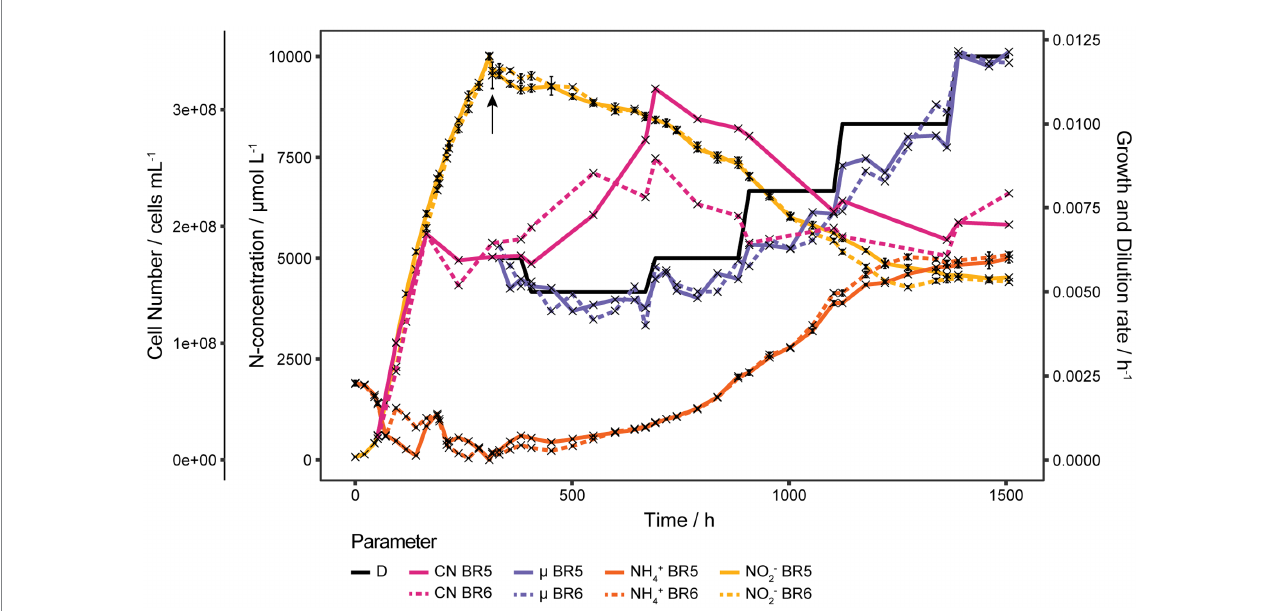
FIGURE 5 Continuous cultures of N. viennensis at high ammonia concentrations. Two continuous cultures gassed with 2 sL L − 1 h − 1 0.5% CO 2 enriched air, operated at D = 0.005 h − 1 to 0.012 h − 1 and the development of cell number (CN), NO 2 − derived μ , NH 4+ and NO 2 − concentrations of the cultures grown in the corresponding reactors BR5 and BR6. Batch cultures were grown with 2 mmol L − 1 NH 4 Cl and 1 mmol L − 1 pyruvate and then fed with medium containing 32 mmol L − 1 NH 4 Cl and 4.75 mmol L − 1 pyruvate to reach a final concentrations of 10 mmol L − 1 NH 4 Cl and 2 mmol L − 1 pyruvate. The relative reduction of pyruvate to NH 4 Cl caused a stagnation of the cell number, for which reason pyruvate was added to the cultures at the end of the feed phase (indicated by the arrow) to increase the concentration to 5 mmol L − 1 . Cell number increased as a result of ROS detoxification by pyruvate, but started to decrease again as NH 4+ increased. Once NH 4+ stabilized at D = 0.010 h − 1 increasing D further did not result in an increase of NH 4+ . NH 4+ and NO 2 − curves show mean values of technical triplicates and error bars represent the standard deviation of the mean. Points with small standard deviation may not have visible error